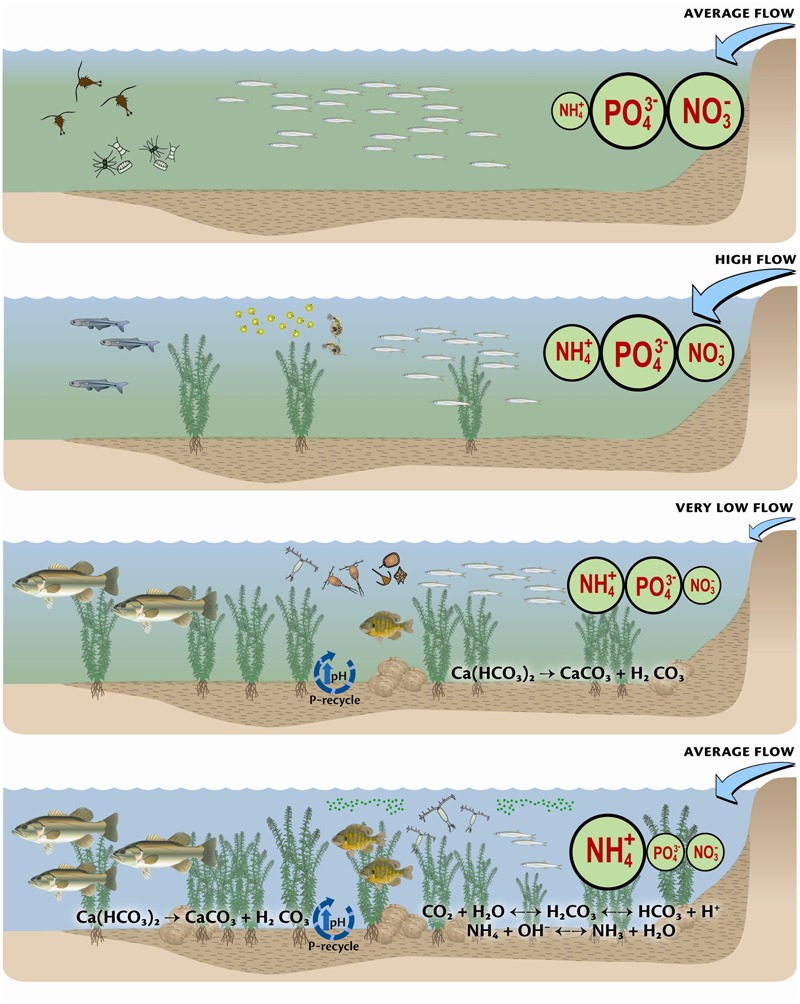
Conceptual depiction of the change over time in major nutrients, flow, dominant biogeochemical processes, and the food web of the Bay Delta. The first panel represents the period from 1975 to ∼1982, when flow was low, and diatoms and Eurytemora were the dominant phytoplankton and zooplankton, respectively, and smelt were common. The second panel represents the period from ∼1982 to 1986 when flow was high, and NH4+ was increasing. During this period the food web began to change. Under very low flow conditions, depicted by the third panel, and representing ∼1987 to 1995, the NH4+ load was high but PO43- began to decrease. The food web also began to change significantly, with changes in the dominant phytoplankton and zooplankton, increasing abundance of macrophytes, increased importance of sediment nutrient processes, and increase in piscivores. Finally, post 1995, NH4+ loads remain high, while PO43- loads are proportionately low. Sediment biogeochemical processes are of increasing importance in nutrient processing, macrophyte production is important and omnivorous fish have increased. At the microbial level, Microcystis is more common and the zooplankton is dominated by cyclopoids, e.g., Limnoithona. Reproduced from Glibert (2012) with permission of the publisher.